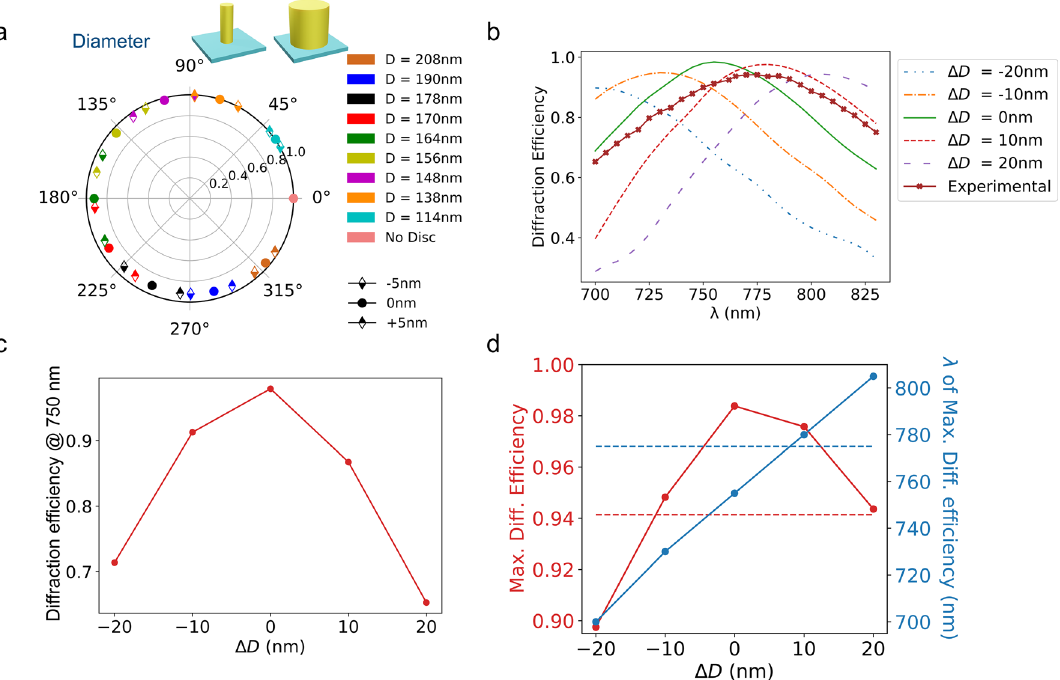
Figure 4. ( a ) Transmission and dephasing induced by an array of silicon nanocylinders on a normally incident (cid:31) = 750 nm plane wave as a function of a change in diameter for the ten selected geometries. ( b ) Diffraction efficiency of a metadeflector in which the Si nanocylinders have their diameter modified from the original value by the same amount as a function of incident wavelength. ( c ) Diffraction efficiency at the design wavelength (cid:31) c = 750 nm as a function of the difference in diameter. ( d ) Maximum diffraction efficiency and wavelength of max. diffraction efficiency as a function of difference in diameter. The red (resp. blue) dotted lines show the measured values of maximum diffraction efficiency and corresponding